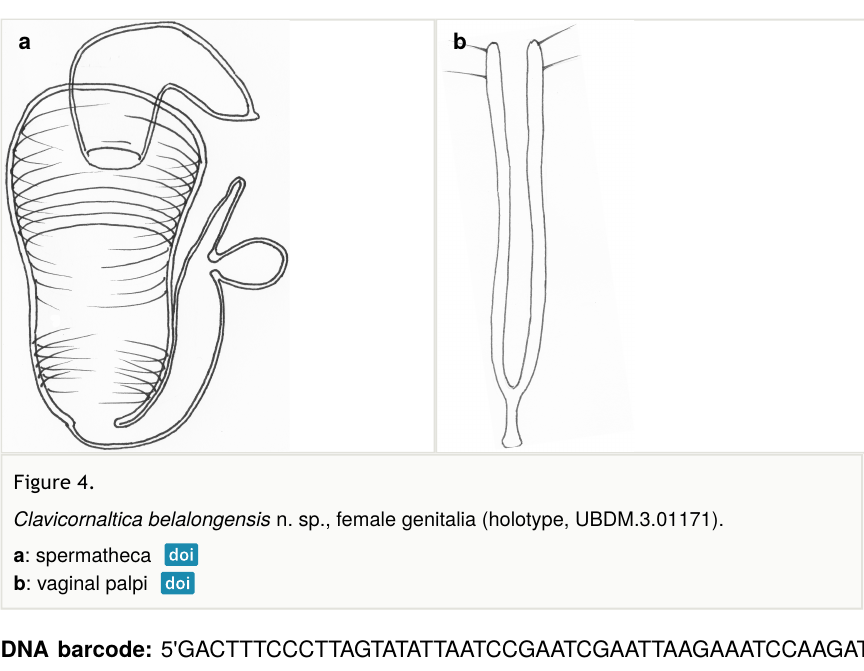
DNA barcode: 5'GACTTTCCCTTAGTATATTAATCCGAATCGAATTAAGAAATCCAAGAT